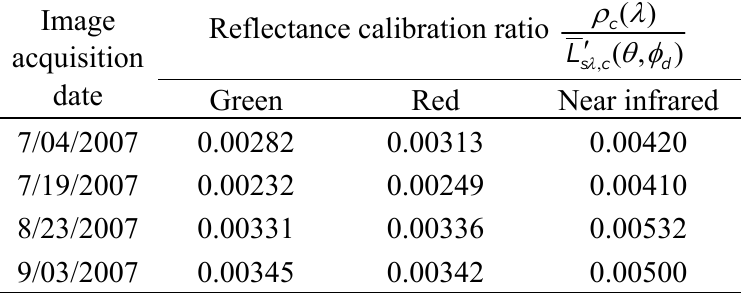
Table 3. Scene reflectance calibration ratios of SPOT multispectral images used in this